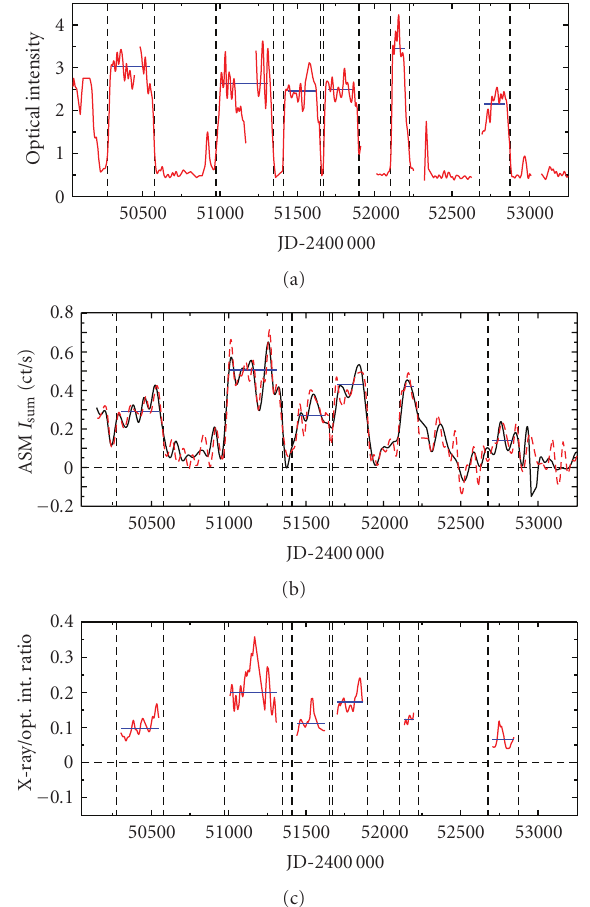
Figure 5: The light curve of the polar AM Her in the optical (a) (AFOEV data) and X-ray band (b) (ASM/ RXTE data). The ratio of the X-ray to the optical intensity is shown in (c). Only HEC13 fits are shown. The dashed vertical lines denote the crossing of the level . Solid horizontal lines denote the average intensity of of 14.3 mag vis the given high state. See Section 2.6 for